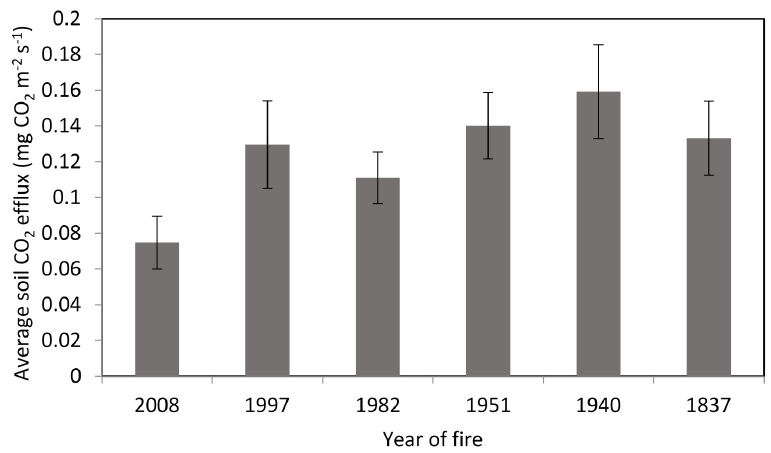
Figure 5. The average soil CO 2 efflux (mg CO 2 m − 2 ·s − 1 ) in a fire chronosequence.